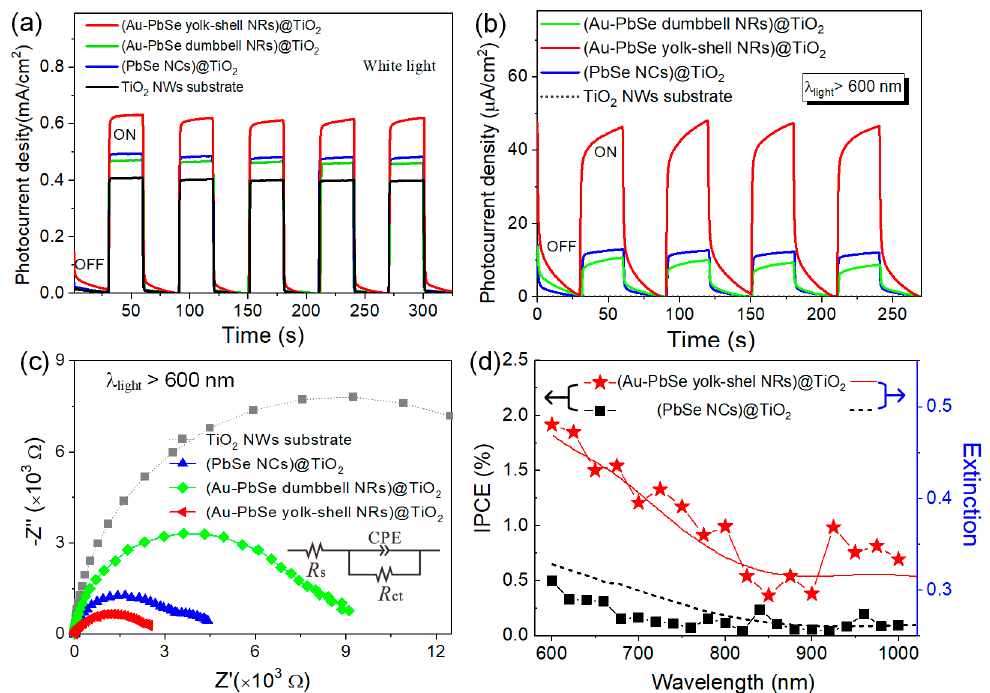
Figure 6. Photocurrent experiments for TiO 2 nanowires (NWs) film photoanodes sensitized with PbSe NCs, Au–PbSe yolk-shell and dumbbell NRs, respectively. The data were collected at an applied potential of 0.1 V vs Ag / AgCl: ( a ) under white light and ( b ) light illumination of λ > 600 nm; ( c ) Corresponding EIS spectra for four parallel photoanodes with light illumination of λ > 600 nm; ( d ) Incident photon to current conversion efficiency (IPCE) plots of (PbSe NCs)@TiO 2 and (Au–PbSe yolk-shell NRs)@TiO 2 in the wavelength range 600–1000 nm. The extinction spectra of PbSe and Au–